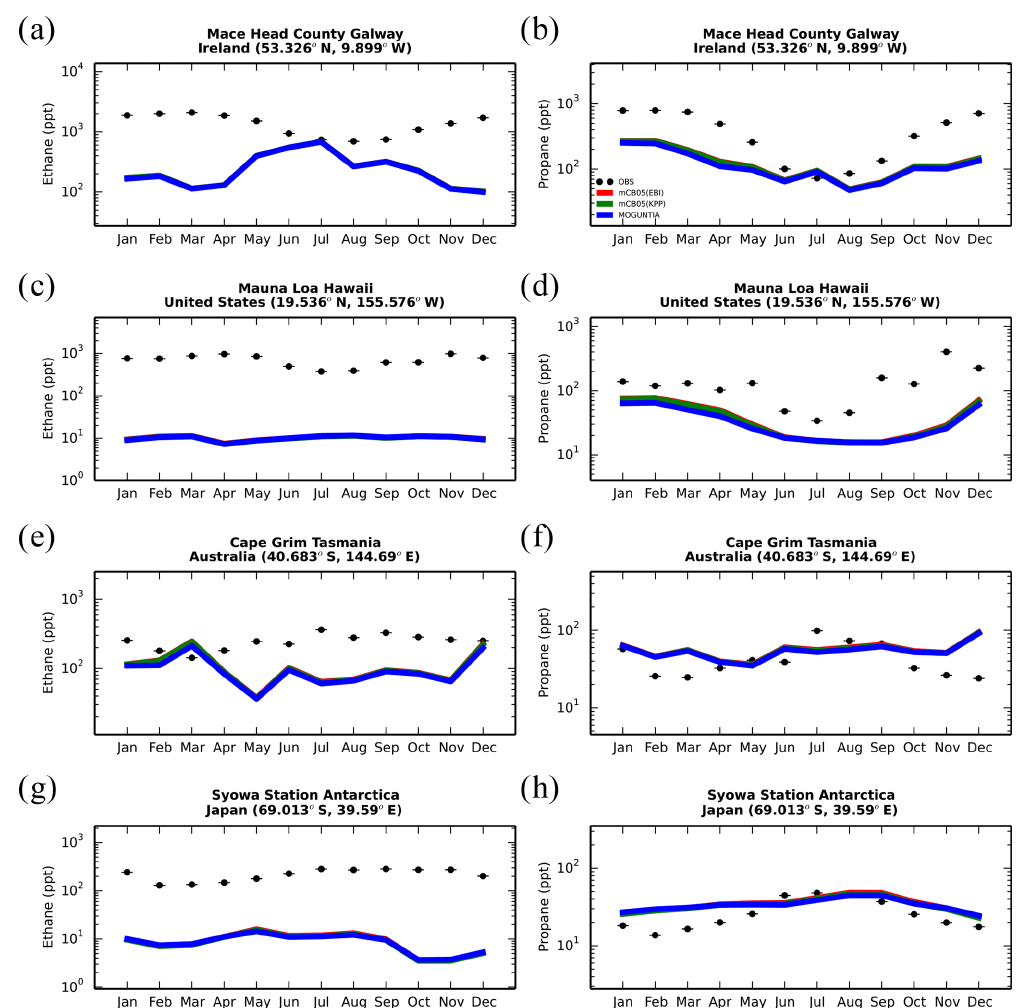
Figure 9. Monthly mean comparison of TM5-MP surface C 2 H 6 (left column) and C 3 H 8 (right column) against flask measurements (black dots; ppt) for the two chemistry schemes, mCB05(KPP) (green line) and MOGUNTIA (blue line), using colocated model output for 2006 sampled at the measurement times; error bars indicate the standard deviation in the monthly means. For comparison, model results of mCB05 with the EBI solver (red line) are also